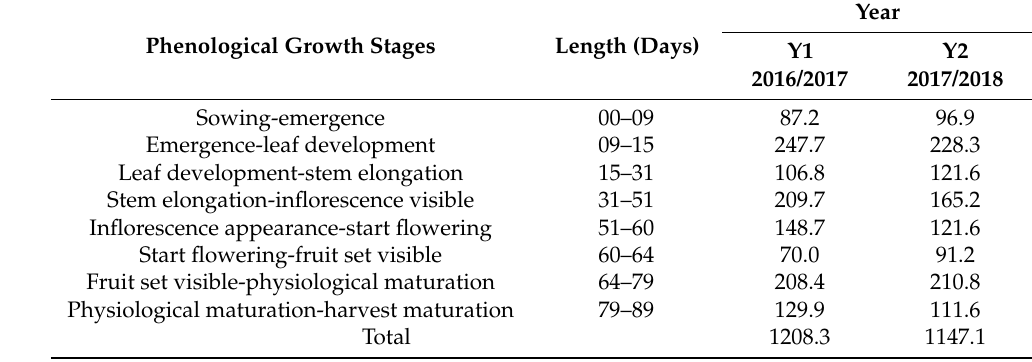
Table 2. Growing degree days (GDD) of the main phenological growth stages of Camelina sativa sowed in autumn 2016/2017 (Y1) and 2017/2018 (Y2).